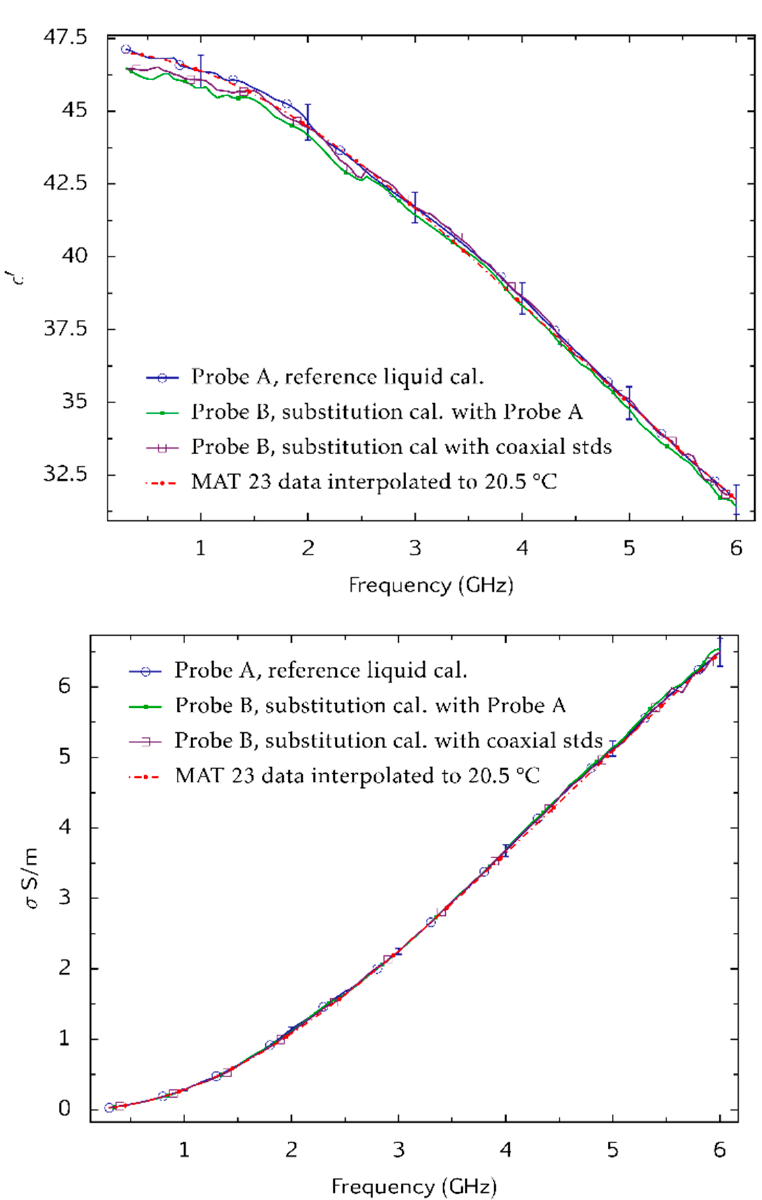
Figure 8. Measurements of the dielectric properties ε ’ ( top ) and σ ( bottom ) of dimethyl sulphoxide made with Probe A (reference liquid calibration) and Probe B (substitution calibration methods). These measurements were made at NPL by using a Rohde and Schwarz model ZVB20 VNA. Reference data [21] is also shown. The measurement temperature was 20.5 °C. Combined Type A and Type B uncertainties are shown for a coverage factor of k = 2 (equivalent to 95% confidence level). These were evaluated by Monte-Carlo modelling [20].